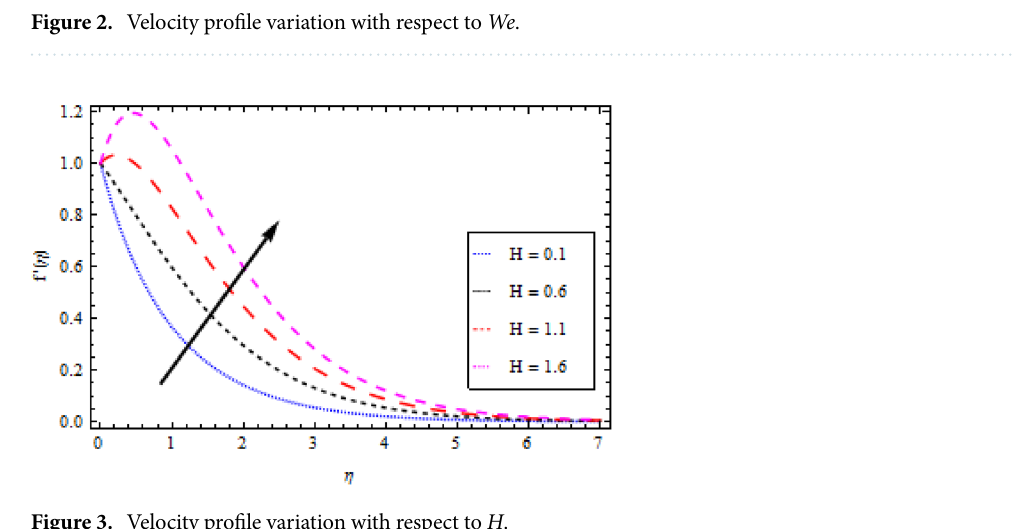
Figure 3. Velocity profile variation with respect to H